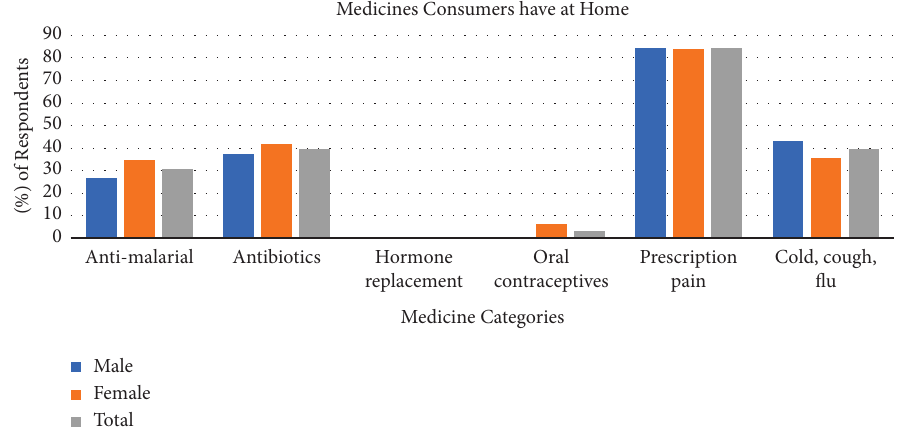
Figure 3: Major types of medications consumers in the Krowor municipality admit to having at home for emergency use. Data represent the means for each group ( n � 400).